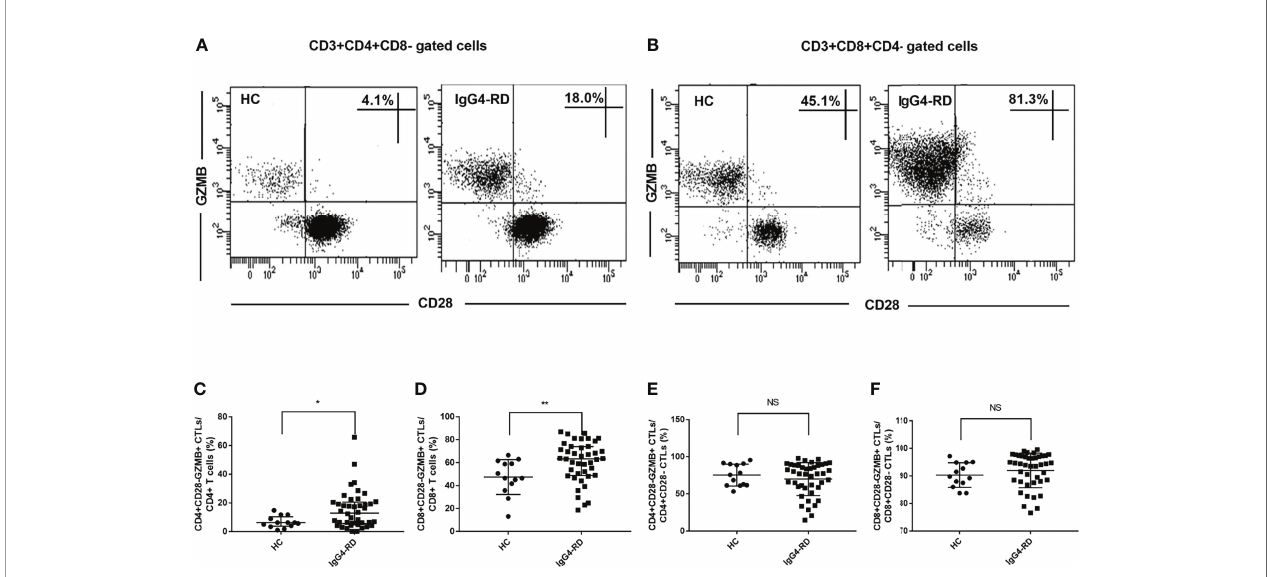
FIGURE 3 | Analysis of the levels of CD28-GZMB+ CTLs in peripheral blood from IgG4-RD patients and healthy controls. Peripheral blood mononuclear cells of IgG4-RD patients ( n = 42) and healthy controls (HCs, n = 13) were obtained, CD3, CD4, CD8, CD28 were detected by fl ow cytometry and GZMB was detected by intracellular staining. (A, B) Representative dot plots of fl ow cytometry analysis. CD4+CD28-GZMB+ CTLs and CD8+CD28-GZMB+ CTLs were shown. (C, D) The percentages of circulating CD4+CD28-GZMB+ CTLs and CD8+CD28-GZMB+ CTLs in CD4 and CD8 T cells were compared between IgG4-RD patients and HCs. (E, F) The proportions of GZMB+ cells in CD4+CD28- CTLs and CD8+CD28- CTLs were compared. The error bars represented the median with an interquartile range. The two-tailed Mann – Whitney test was used to compare two groups. ∗ P < 0.05; ∗∗ P < 0.01; NS, not signi fi